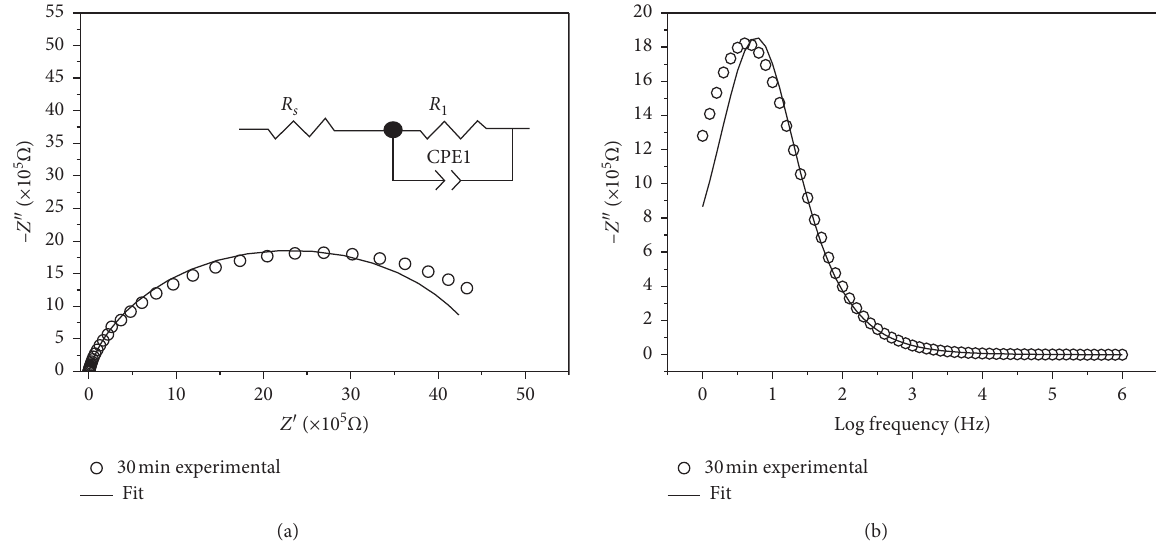
Figure 4: (a) Nyquist plot and (b) bode plot for the ITO/ZnO/CdS/CuO:Co/Ag heterojunction solar cell at t � 30min. The insert shows the equivalent circuit for one process.